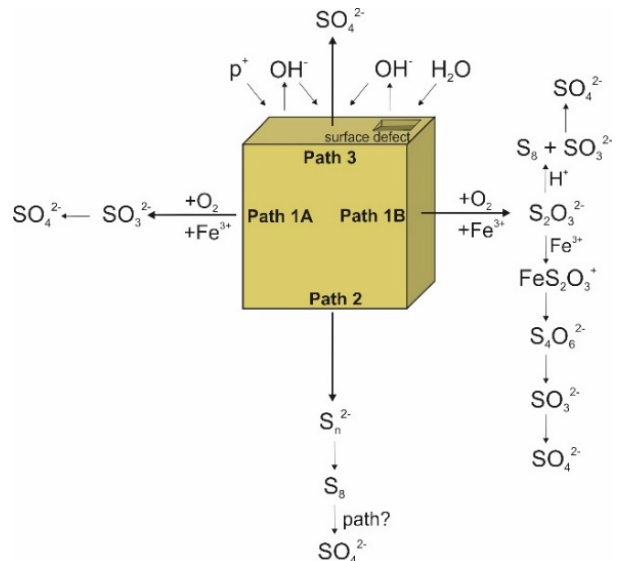
Figure 2. Schematic representation of different sulfide oxidation pathways: Paths 1A and 1B represent thiosulfate oxidation pathways where thiosulfate detaches and where the S–S bond breaks instead of the Fe–S bond releasing sulfite directly [90]. Path 2 represents the sulfide–polysulfide-elemental sulfur pathway of monosulfides [90] and Path 3 represents the defect/photochemically driven pathway where surface electron defects can initiate pyrite oxidation by surface water and drive the subsequent sulfur oxidation by OH − [93]. Figure modified from Druschel and Borda [94].